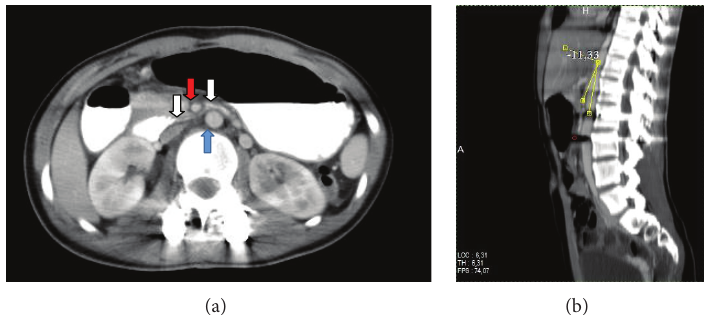
Figure 3: (a) Duodenum (white arrows) compressed between the aorta (blue arrow) and the superior mesenteric artery (red arrow). (b) The angle between aorta and SMA (11 ∘ ).